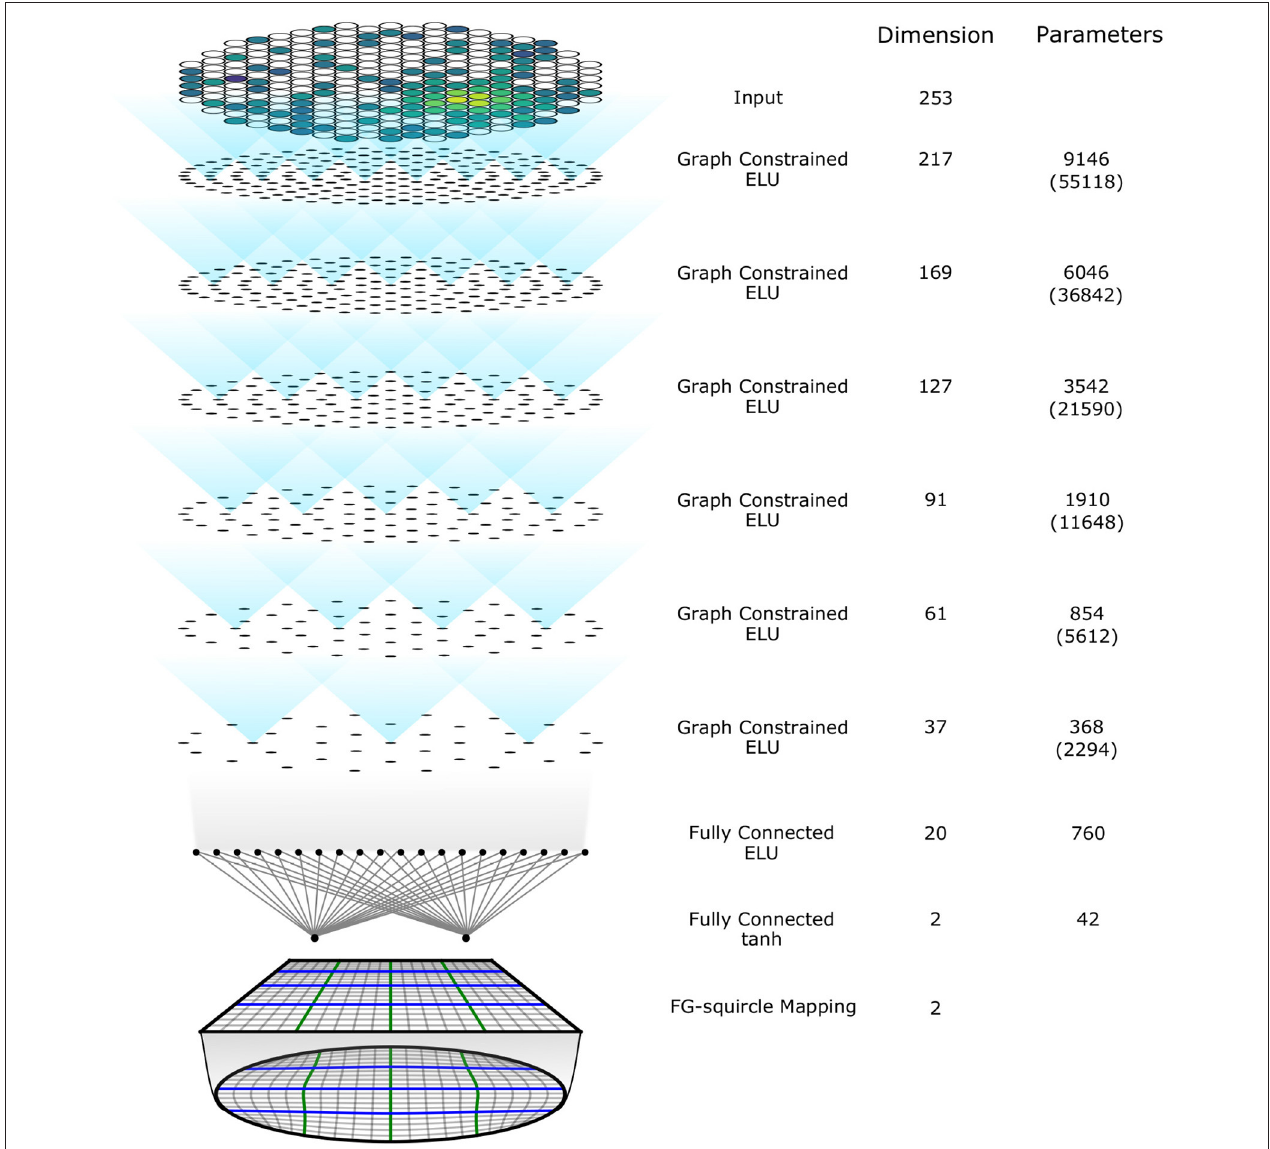
FIGURE 5 | The architecture of the implemented prototype model. The dots in graph constrained layers represents the assigned positions of the neurons. The numbers in brackets are the number of parameters if the neurons are fully connected for graph constrained layers.